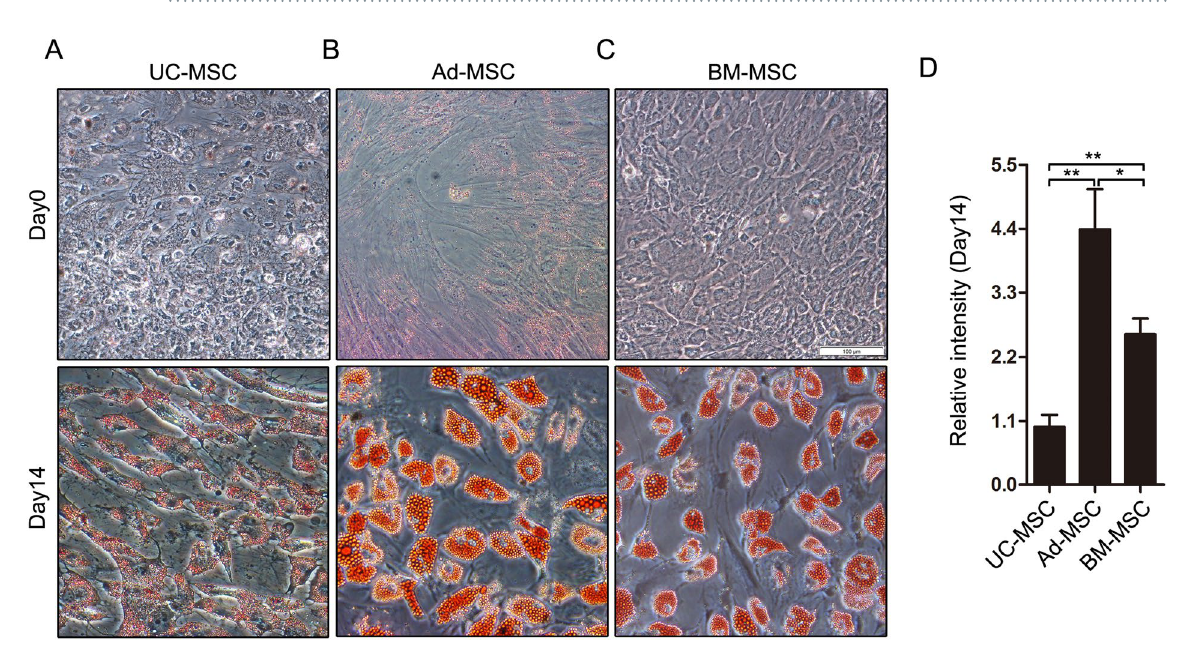
Figure 3. Comparison of adipogenic differentiation in the three tissues-derived MSCs by oil red O staining. UC-MSC, Ad-MSC and BM-MSC were incubated with or without adipogenic medium for 14 days. Then the cells were stained with oil red O and captured using the IX71 Olympus microscope. The staining of UC-MSC ( A ), Ad-MSC ( B ) and BM-MSC ( C ) at Day 0 and Day 14 of adipogenic differentiation was presented. ( D ) The relative quantification of the staining at Day 14 was analyzed and shown. * P < 0.05 and ** P < 0.01, Student’s